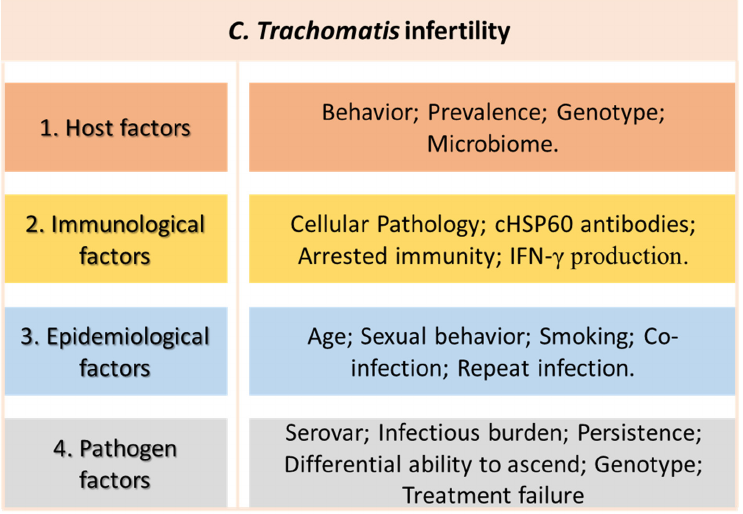
Figure 2. Potential factors involved in the development of Chlamydial infertility in women. Of note, it must be highlighted that, with the ageing process, Chlamydia trachomatis is eliminated from the host and is no longer detected by PCR. Therefore, the effective ap- proach to detecting past infections that may be responsible for infertility is through IgG- specific bacterium antibodies that remain over time [102].